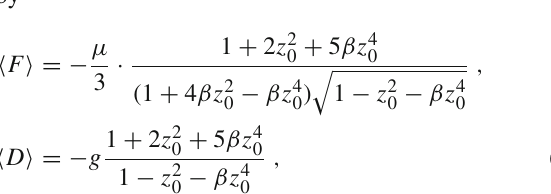
Fig. 8 The scalar potential (7)(8) for the canonical inflaton ϕ ( α = 3, positive β ) and different choices of β and λ , compared to the α -attractor potential (46)